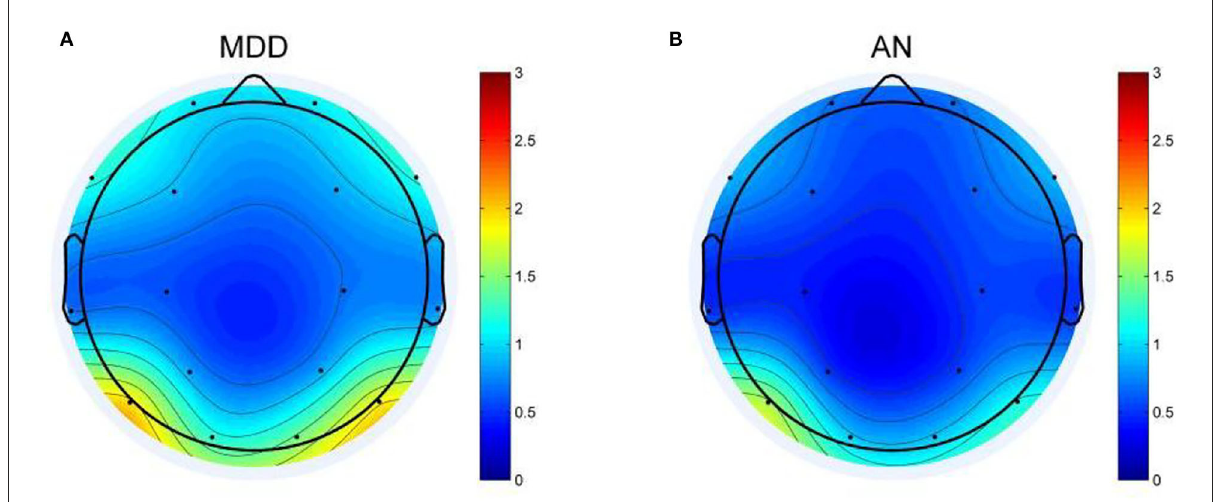
FIGURE1 Topographic map of EEG power spectrum in the theta band for depression group (MDD) and anxiety group (AN). (A) The EEG power spectrum topography map of MDD group. (B) The EEG power spectrum topography map of AN group. The diagram above shows the difference in the energy distribution between the two groups. The blue part represents low EEG power, and the red part represents high EEG power. The darker the blue, the lower the power, and the darker the red, the higher the power.